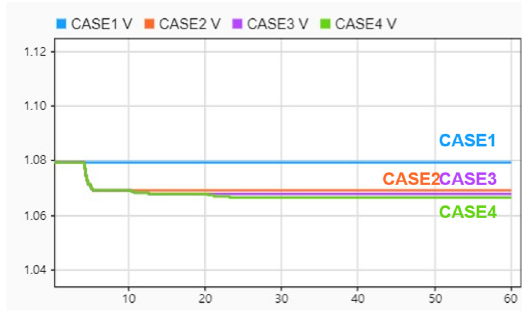
Figure 18. PCC voltage of the G2 inverter.